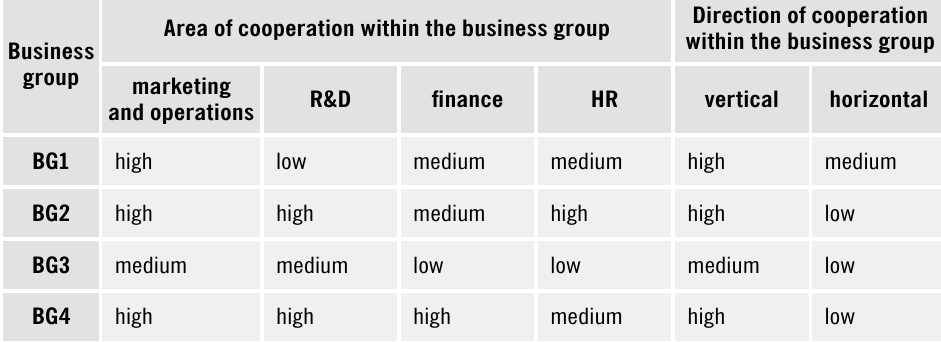
Table 1. Cross-case comparison of cooperation within business groups Area of cooperation within the business group